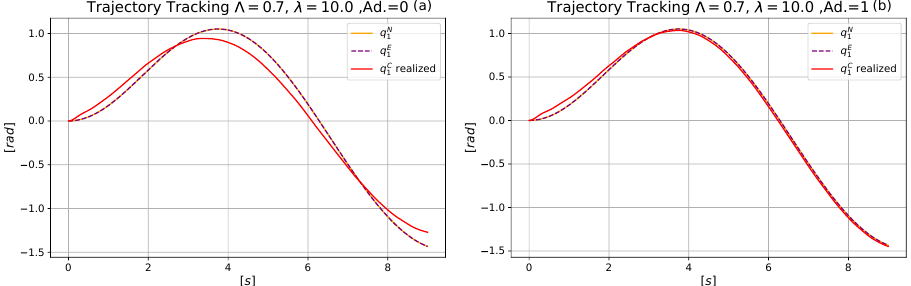
Figure 14. Trajectory tracking for the small amplitude and circular frequency of the nominal trajectory. ( a ): Non-adaptive, ( b ): adaptive control.